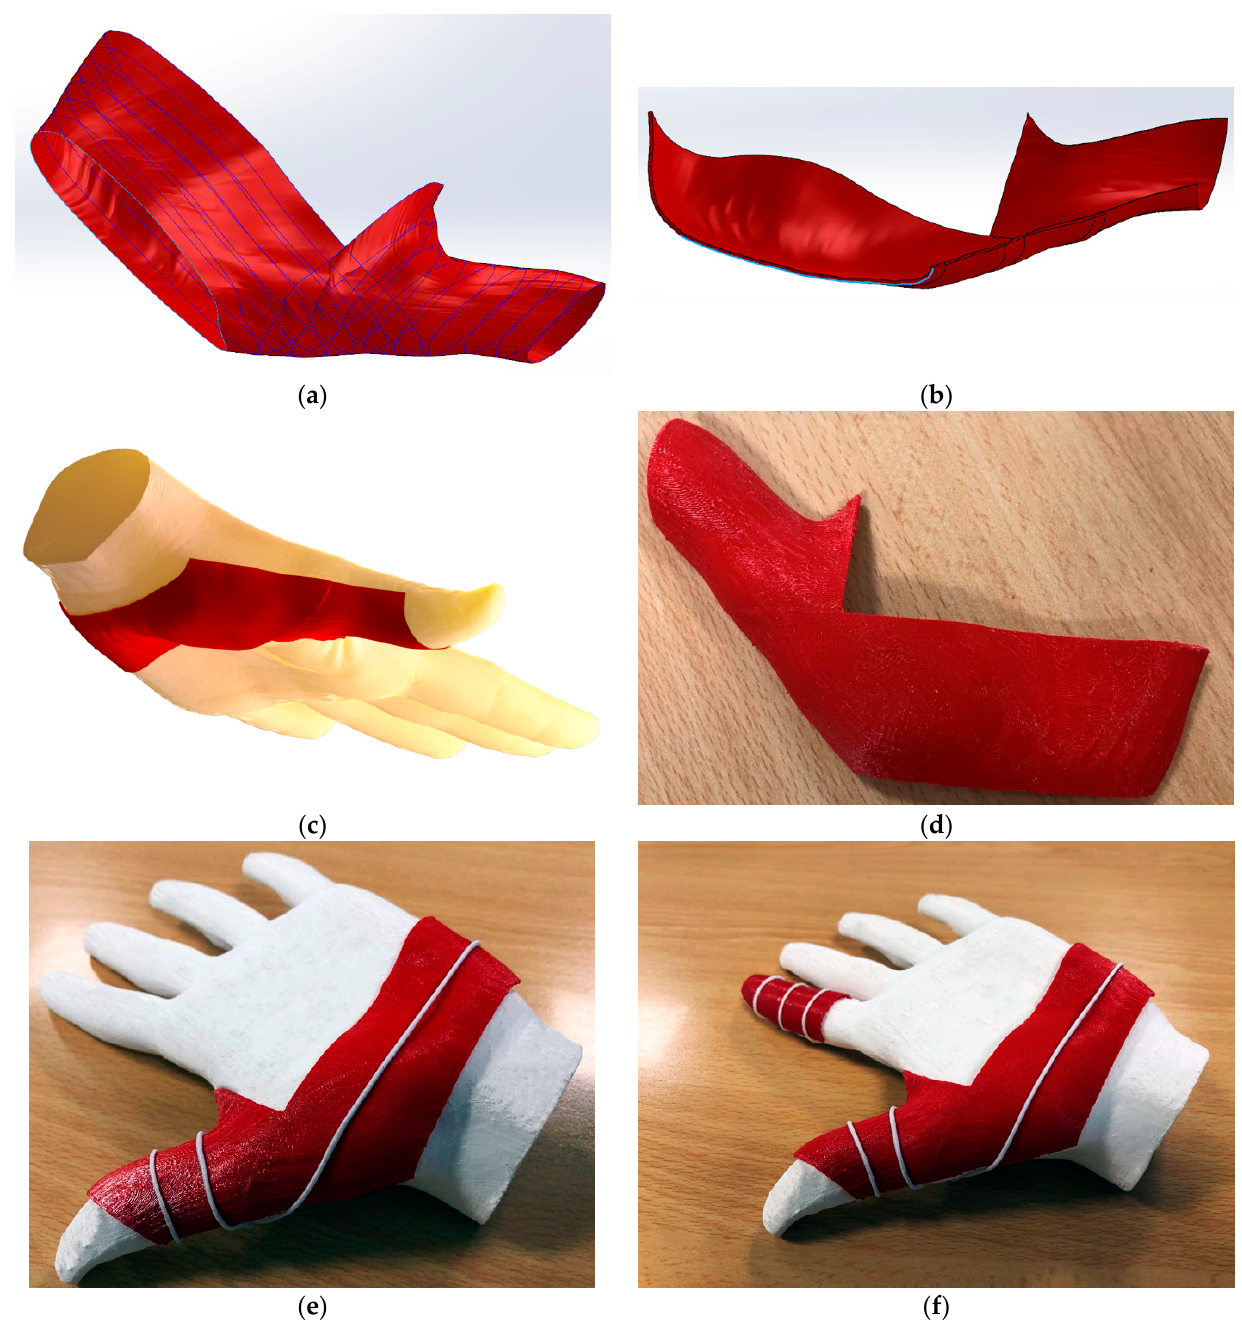
Figure 10. User-tailored thumb orthosis: ( a ) Boundary surfaces generated for the thumb orthosis.; ( b ) Thumb orthosis CAD image; ( c ) CAD image of the thumb orthosis dressing on a human hand; ( d ) Printed thumb orthosis; ( e ) Thumb orthosis dressing on a 3D-printed sample of the human hand model used for the design process; ( f ) Forefinger and thumb orthoses dressing a 3D prototype of the human hand model used during the design process.